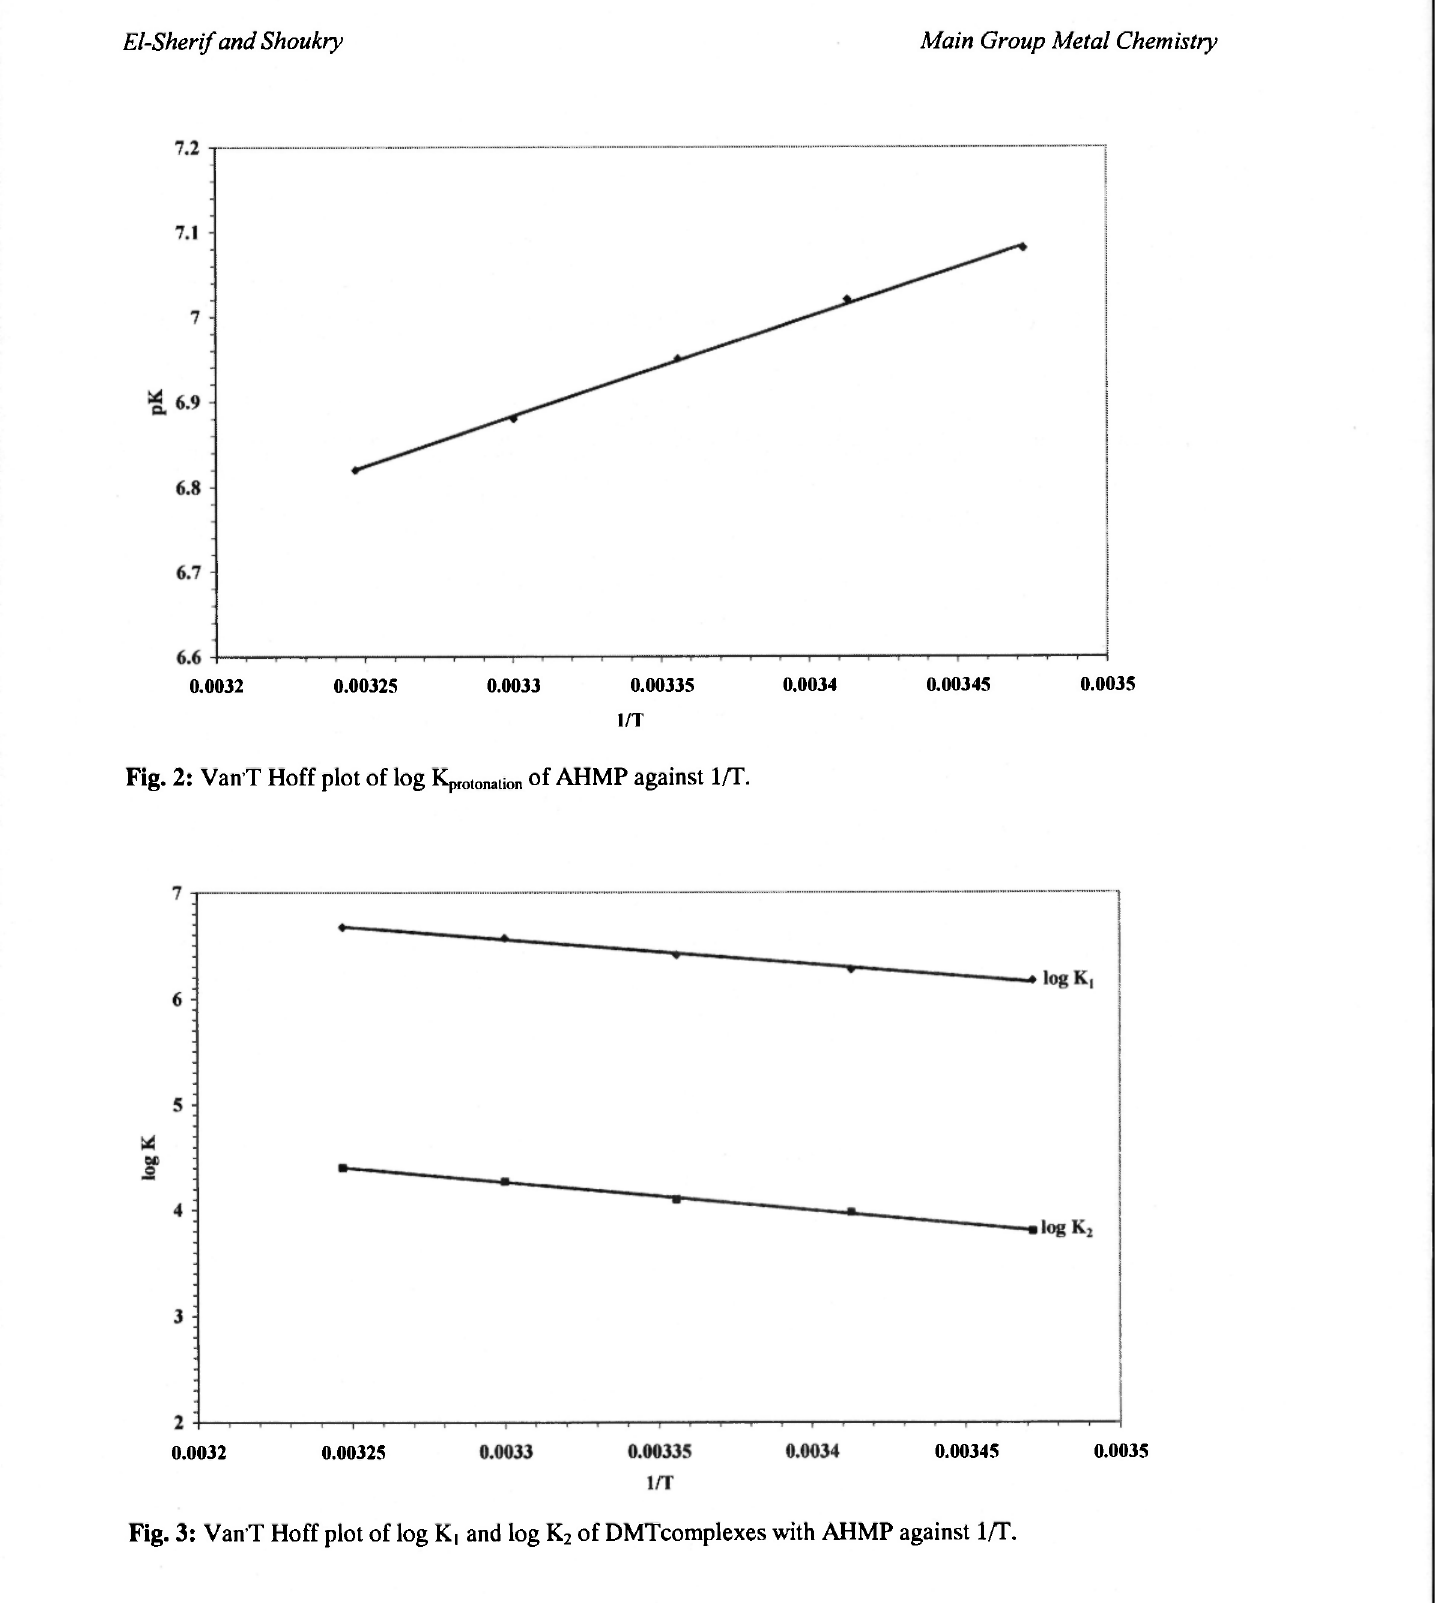
Fig. 3: Van'T Hoff plot of log K, and log K 2 of DMTcomplexes with AHMP against